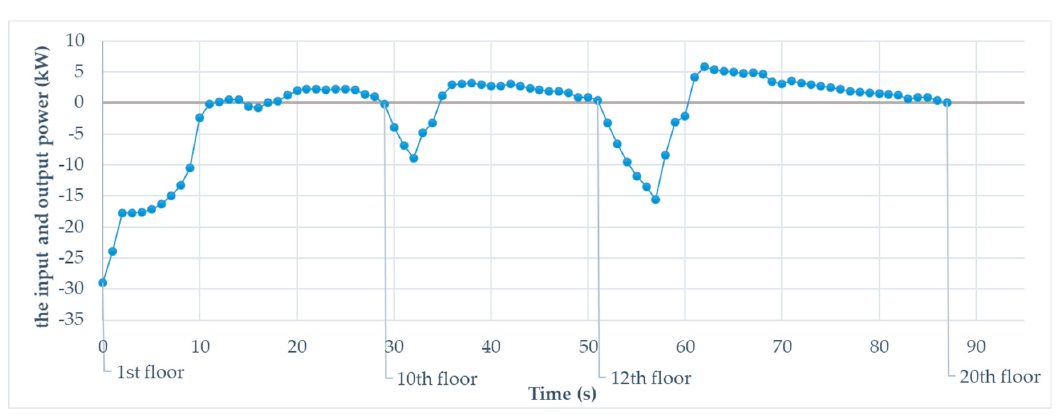
Figure 8. The input and output power of the supercapacitor at the upgoing state [47].